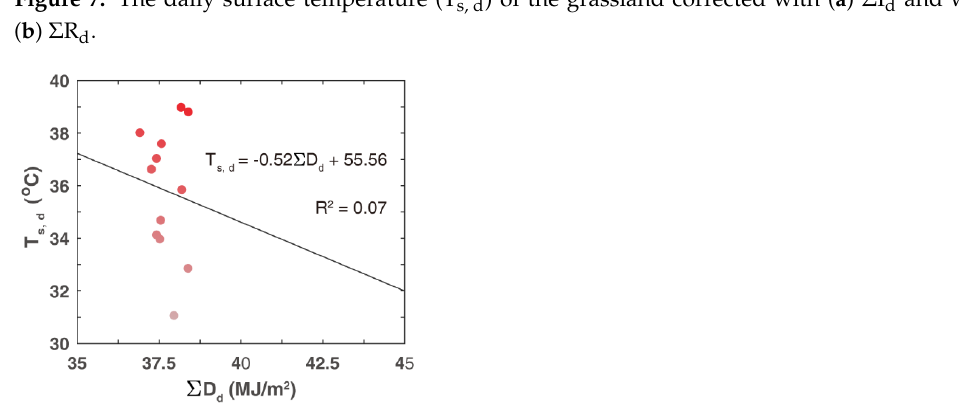
Figure 8. The daily grassland surface temperature (T s,d ) did not vary linearly with daily down- welling long-wave radiati on Σ D d .